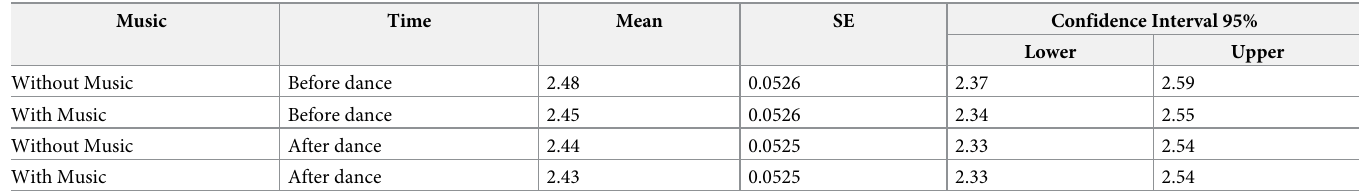
Table 3. Descriptive data.